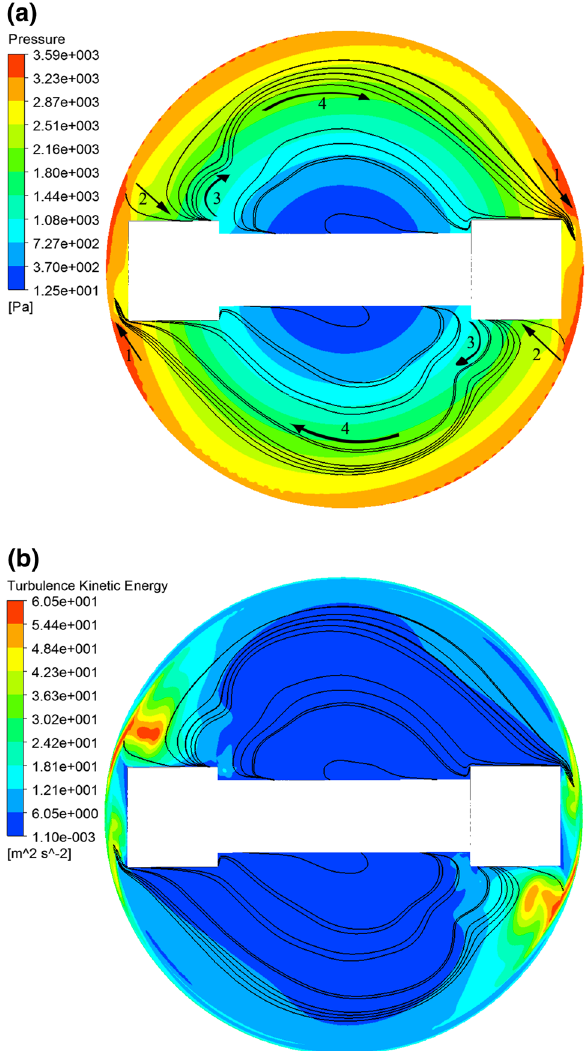
Fig. 6 a Pressure nephogram and the streamlines of particles rela- tive to the rotating arm and b turbulent kinetic energy nephogram and the streamlines of particles relative to the rotating